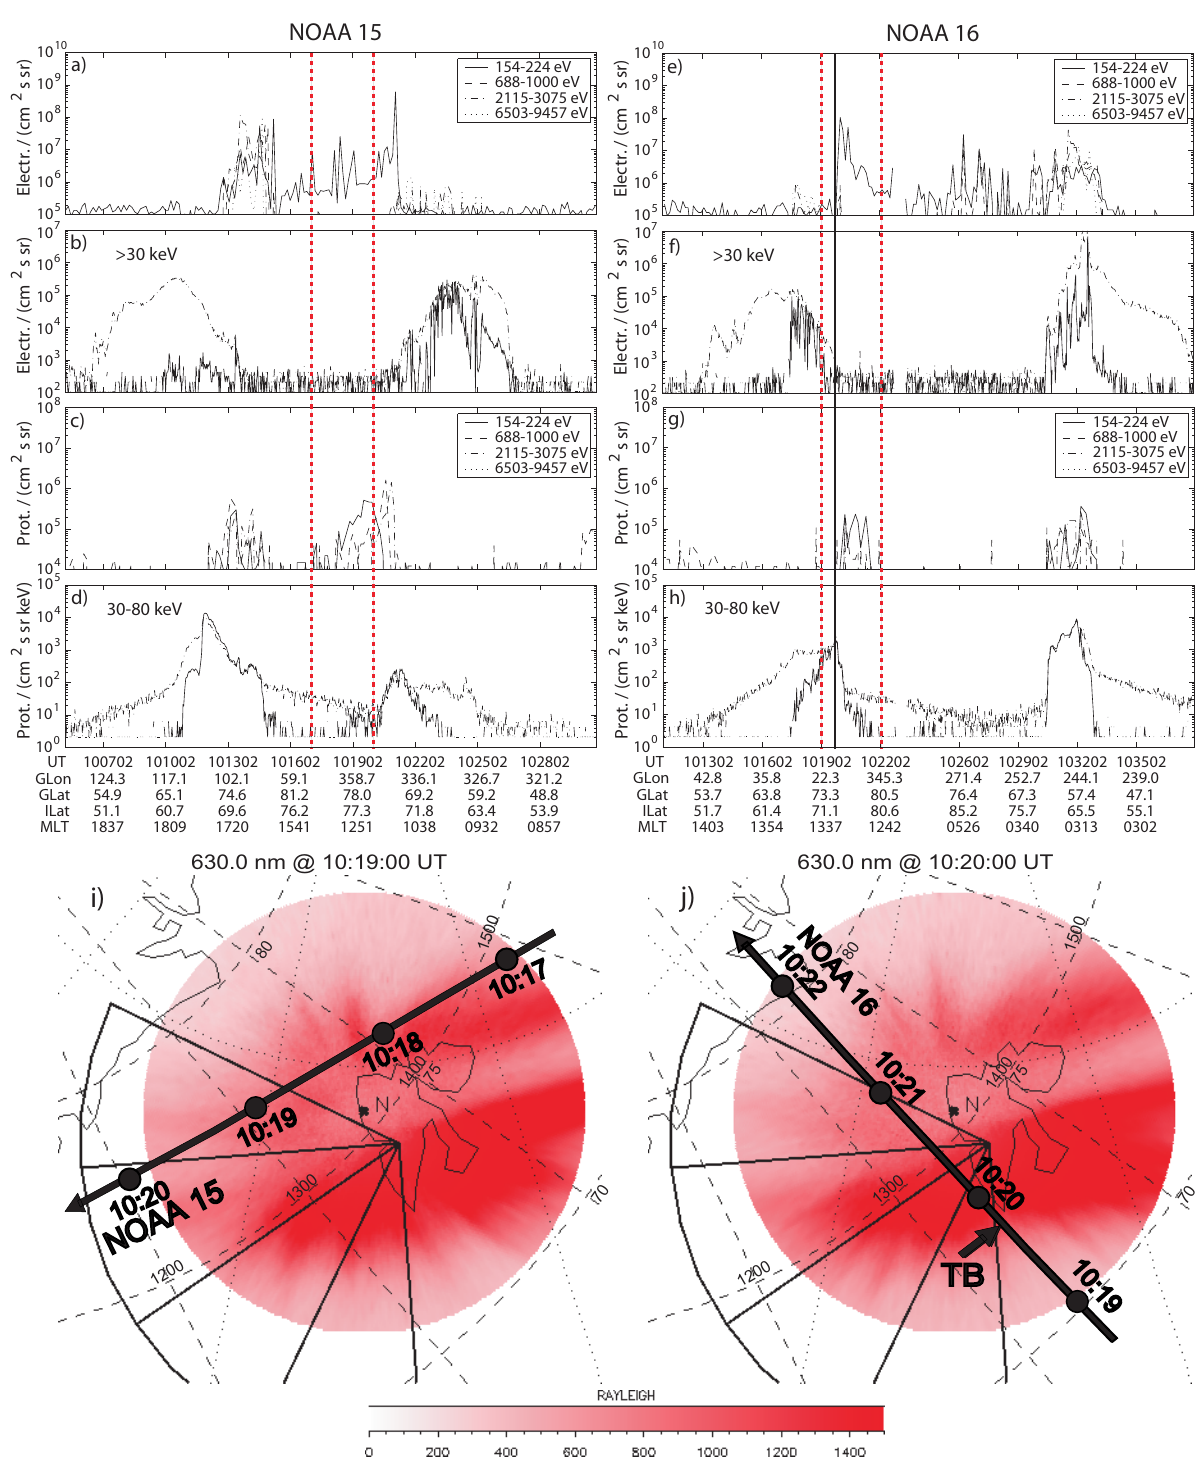
Fig. 7. Particle observations from the NOAA 15 and 16 spacecraft and the two trajectories overlaid on the 630-nm cusp aurora. Panels (a) and (e) show precipitating fluxes from four low-energy electron bands, and panels (c) and (g) from four ion bands. Panels (b) and (f) plot fluxes of energetic electrons, and panels (d) and (h) energetic ions. In these four panels (b, d, f, h) solid lines show precipitating fluxes and dashed lines show local mirroring fluxes. Panels (i) and (j) show the two spacecraft trajectories relative to images of the 630.0-nm aurora, the magnetic grid, and the EISCAT Svalbard radar’s field-of-view. In panel j the electron trapping boundary is indicated with